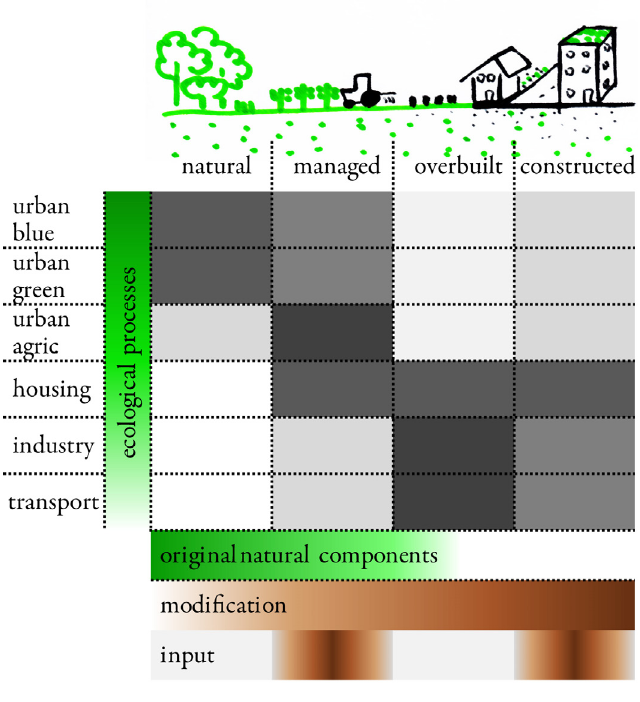
Figure 1: Types of urban ecosystems. The darker the grey the higher the potential proportion of the urban ecosystem type within the individual urban structure classes. Accordingly, the green colour gradient indicates the natural components remaining and the ecological processes taking place. The brown colour scheme illustrates human input and modification the darker the colour the higher is the human